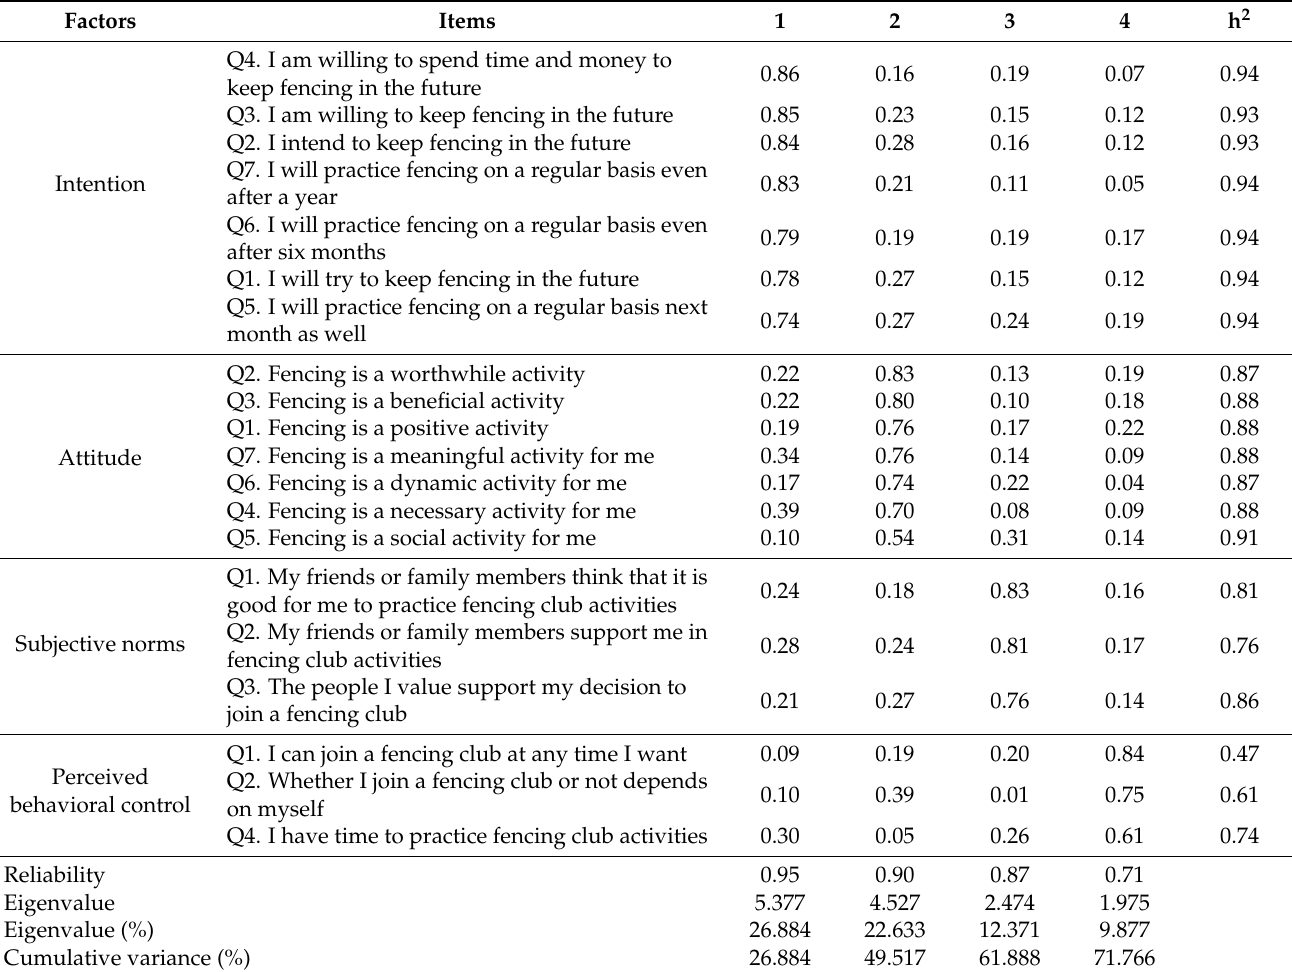
Table 1. Results of exploratory factor analysis (EFA) for Theory of Planned Behavior (TPB) ( n =